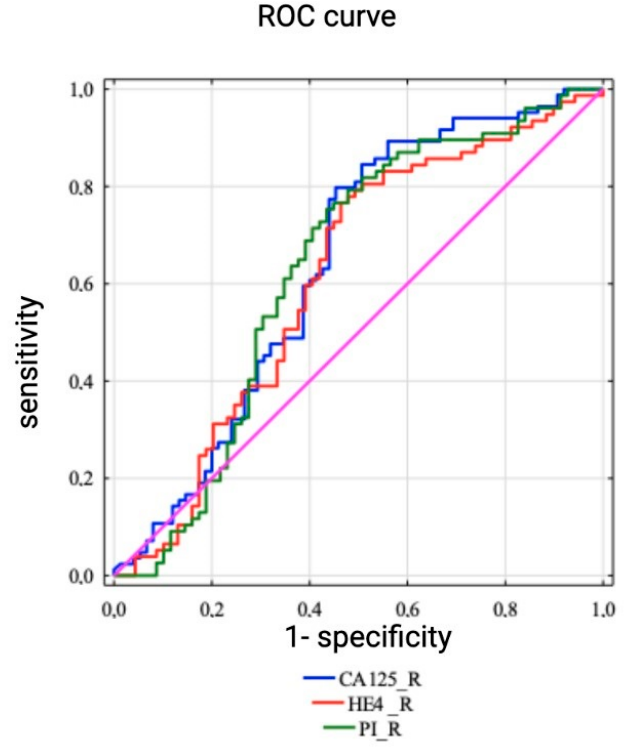
Figure 1. ROC curves to assess the risk of recurrence in the whole population using the HE4 marker.